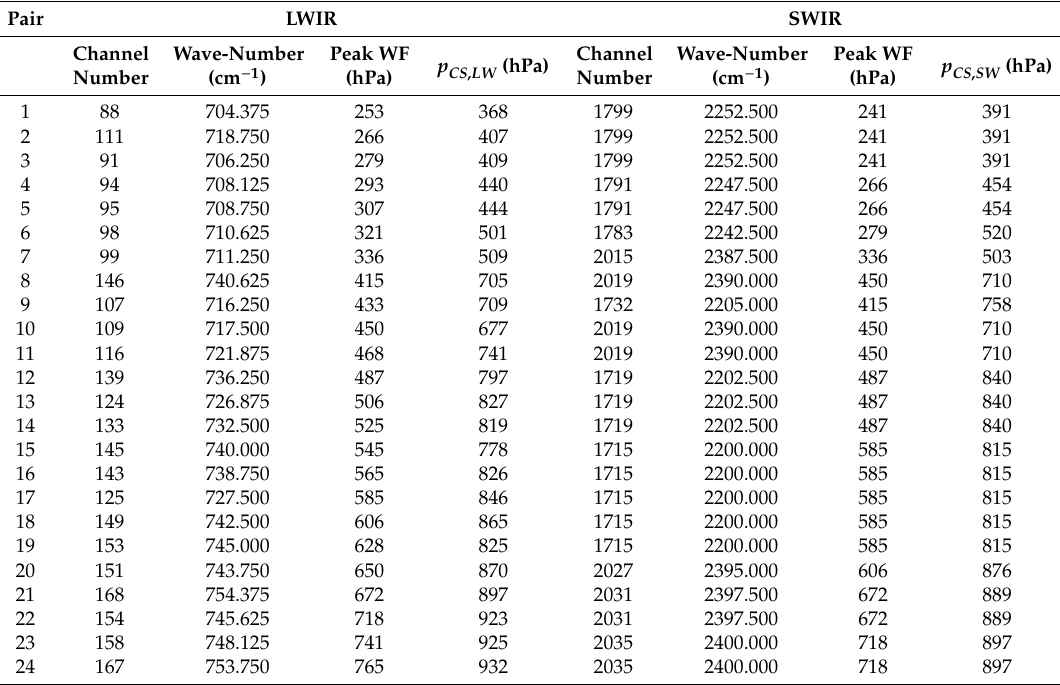
Table 4. Same as Table 3 except for the 24 pairs using the original method.